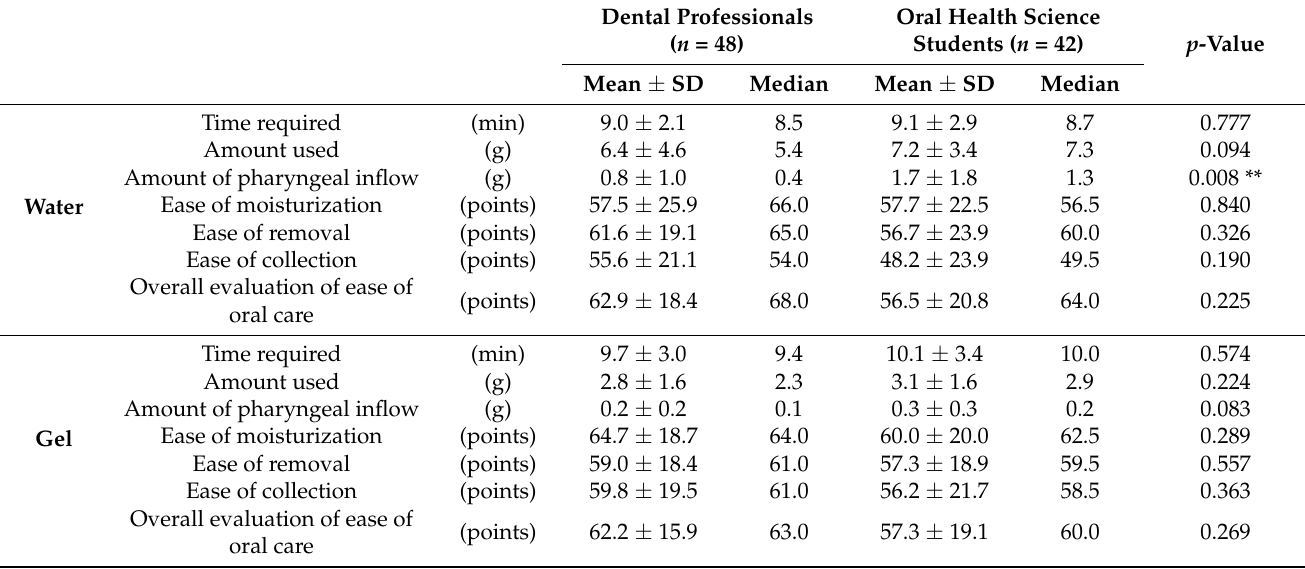
Table 4. Comparison of oral care in each group of dental professionals and students.